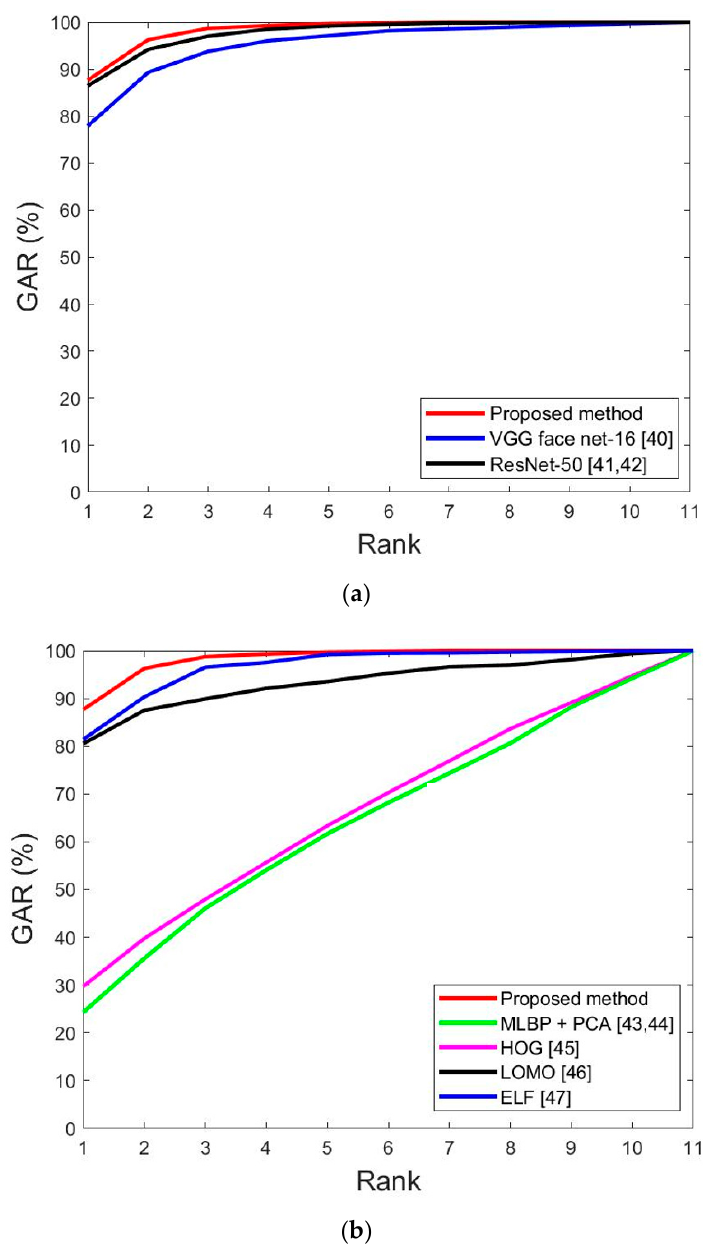
Figure 10. Cumulative match characteristic (CMC) curves of the proposed and previous methods on DFB-DB2. ( a ) Face image recognition results by the proposed and previous methods and ( b ) face and body image recognition results via the proposed and previous methods.